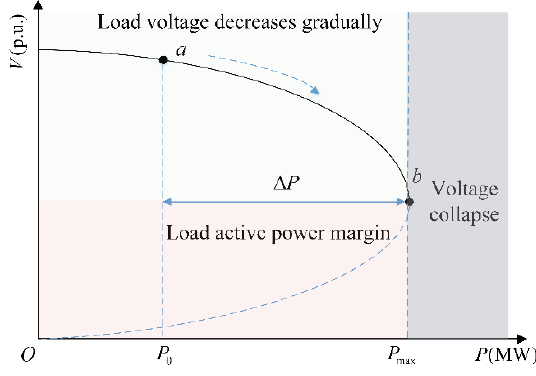
Figure 1. Depiction of load active power